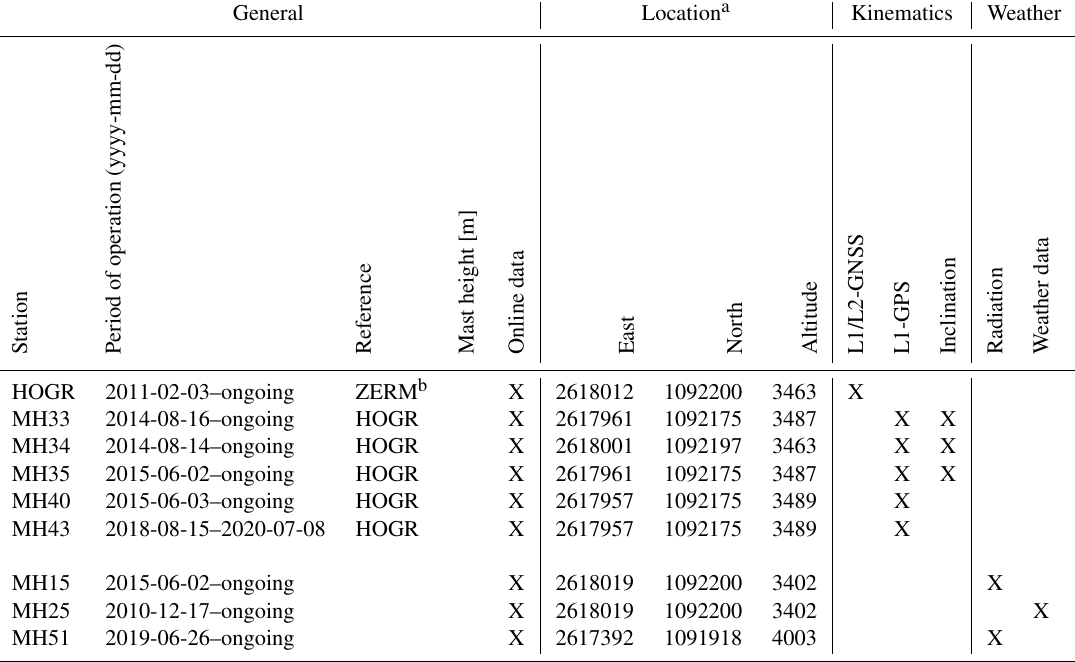
Table A3. Per position overview of the sensors in the Matterhorn field site. General Location a Kinematics Weather